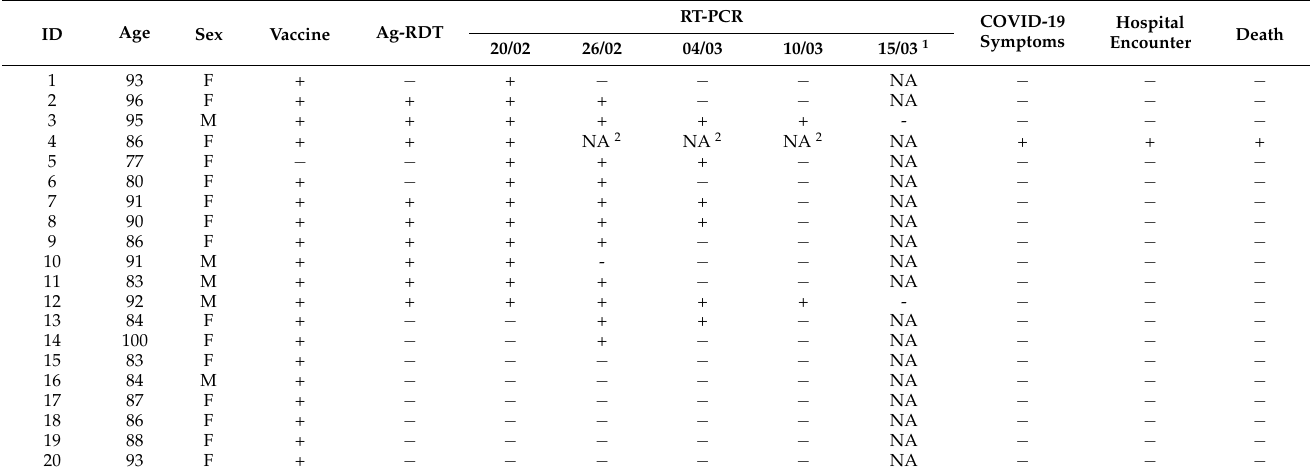
Table 1. Characteristics of positive and negative